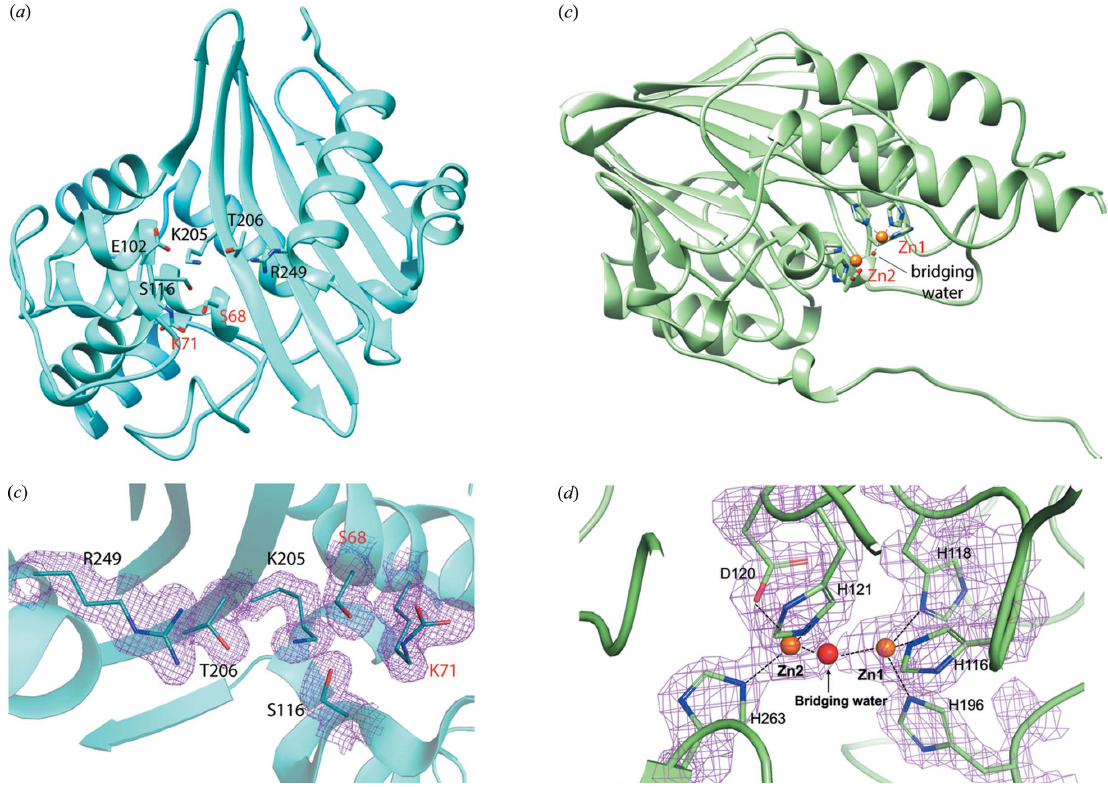
Figure 5 Room-temperature SSX crystal structures of class B and D (cid:2) -lactamases. ( a ) Crystal structure of DBL from C. pinensis determined at 1.80 A˚ . ( b ) Crystal structure of class L1 MBL from S. maltophilia determined at 1.85 A˚ . 2 mF o (cid:3) DF c electron density maps calculated for active sites of C. pinensis DBL ( c ) and L1 MBL ( d ). Difference electron density maps contoured at the 1.2 (cid:3)